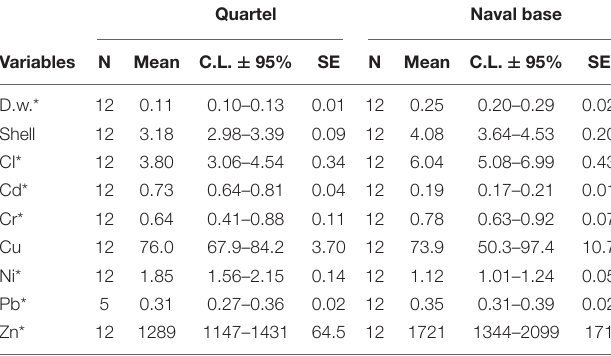
TABLE 1 | Descriptive statistics and Student’s t -test. Quartel